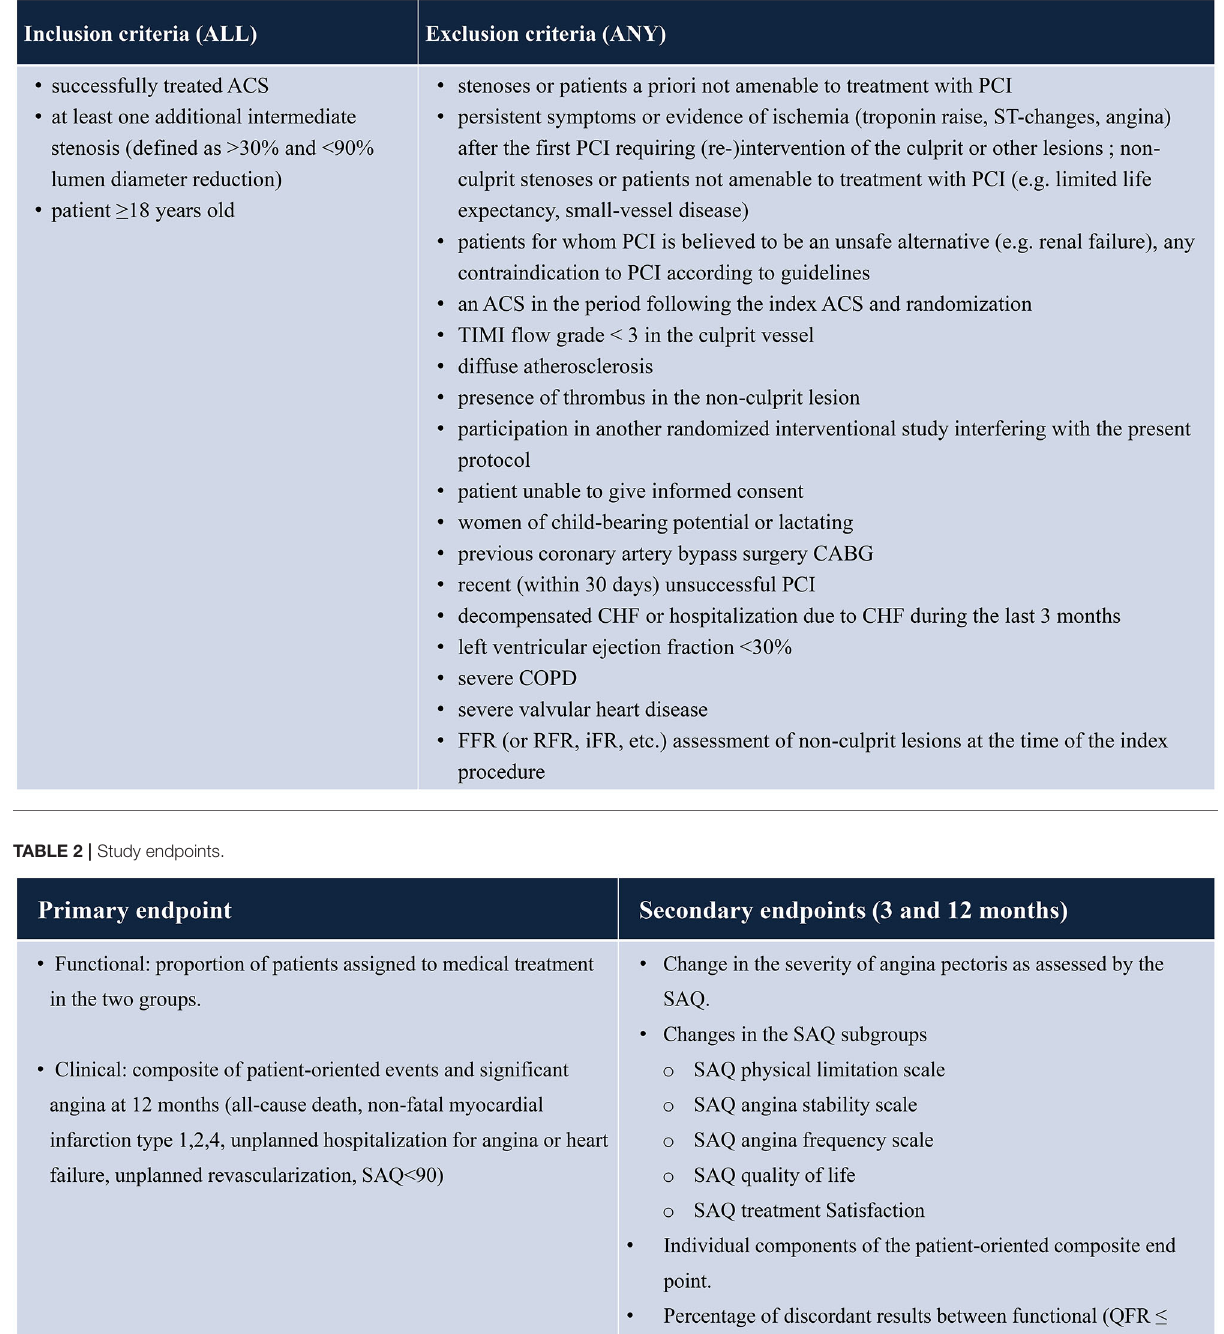
TABLE 1 | In- and exclusion criteria.